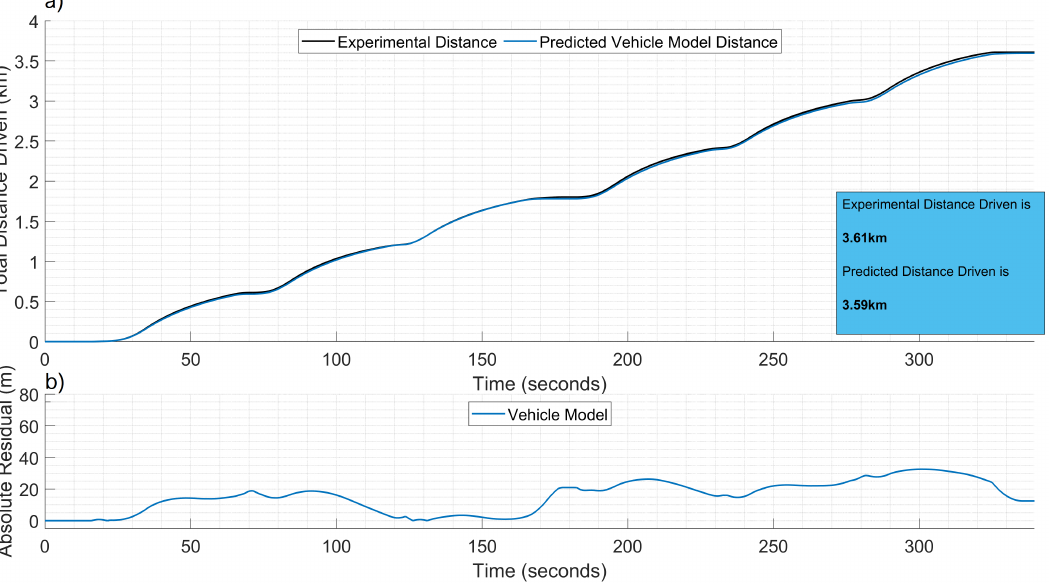
Figure 17. Test #4.1. Electric range prediction: ( a ) total distance traveled and ( b ) instantaneous absolute